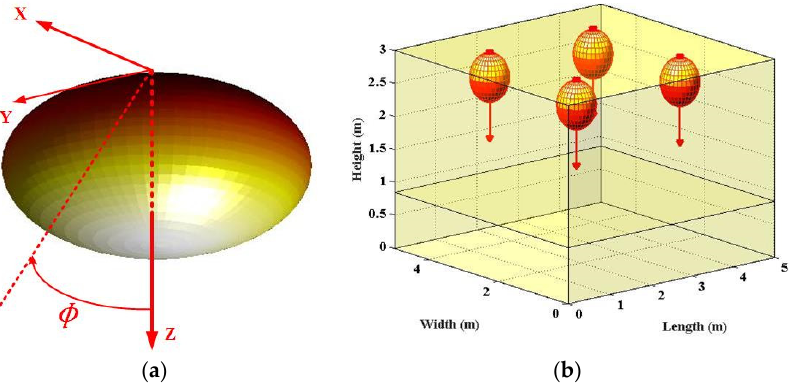
Figure 1. ( a ) 3D spatial optical beam of Lambertian LED; ( b ) Lambertian LED-applied indoor scenario, respectively.